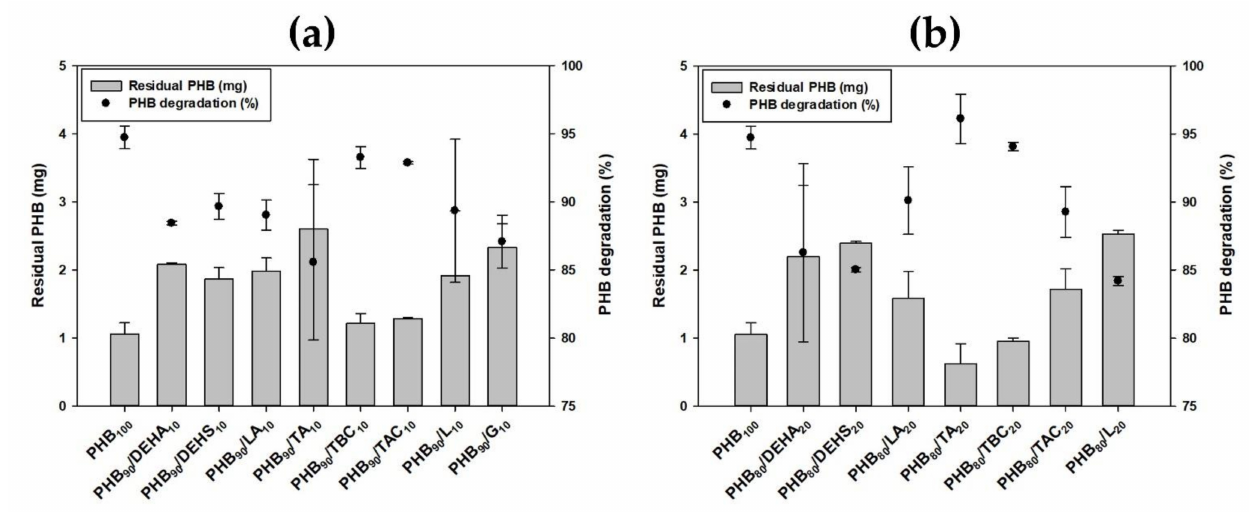
Figure 3. The comparison of degradation of ( a ) 10% plasticized and ( b ) 20% plasticized PHB films by Microbulbifer sp.